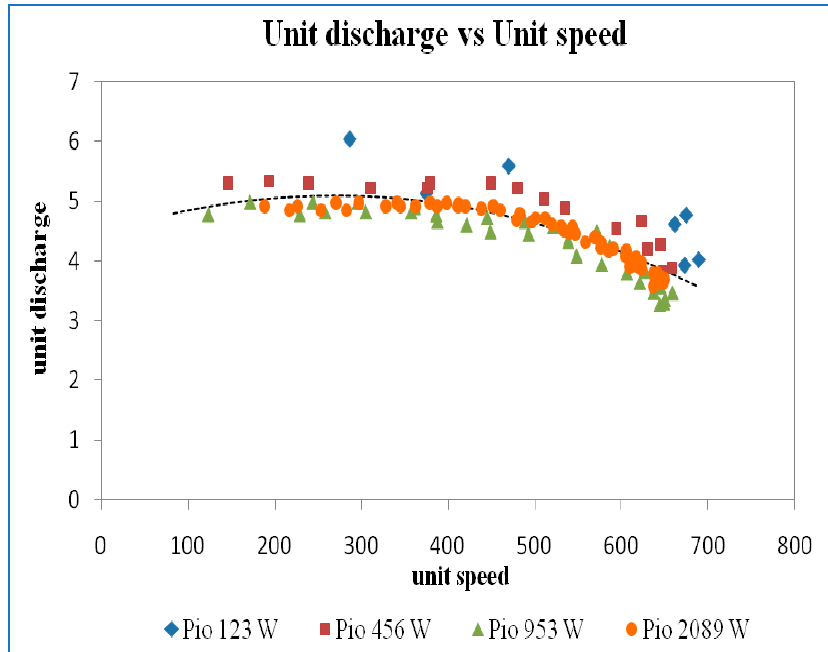
Figure 28. Unit discharge vs. unit Speed at a guide vane opening of 13 mm.